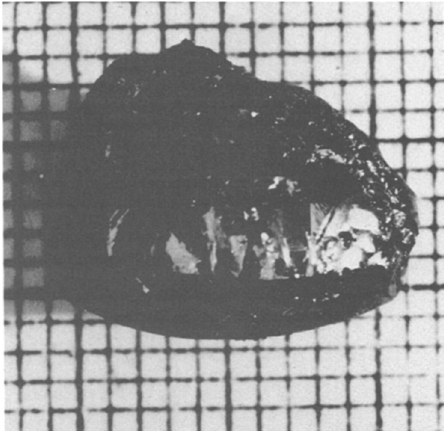
Figure 3: Photograph of electrodeposited Si weighing 1.6g produced during an experiment from a BaO – SiO 2 – BaF 2 melt ( 22.2:63.2:14.5mol% ) of 125g for 50h [ 87 ] . Permission from Electrochemical